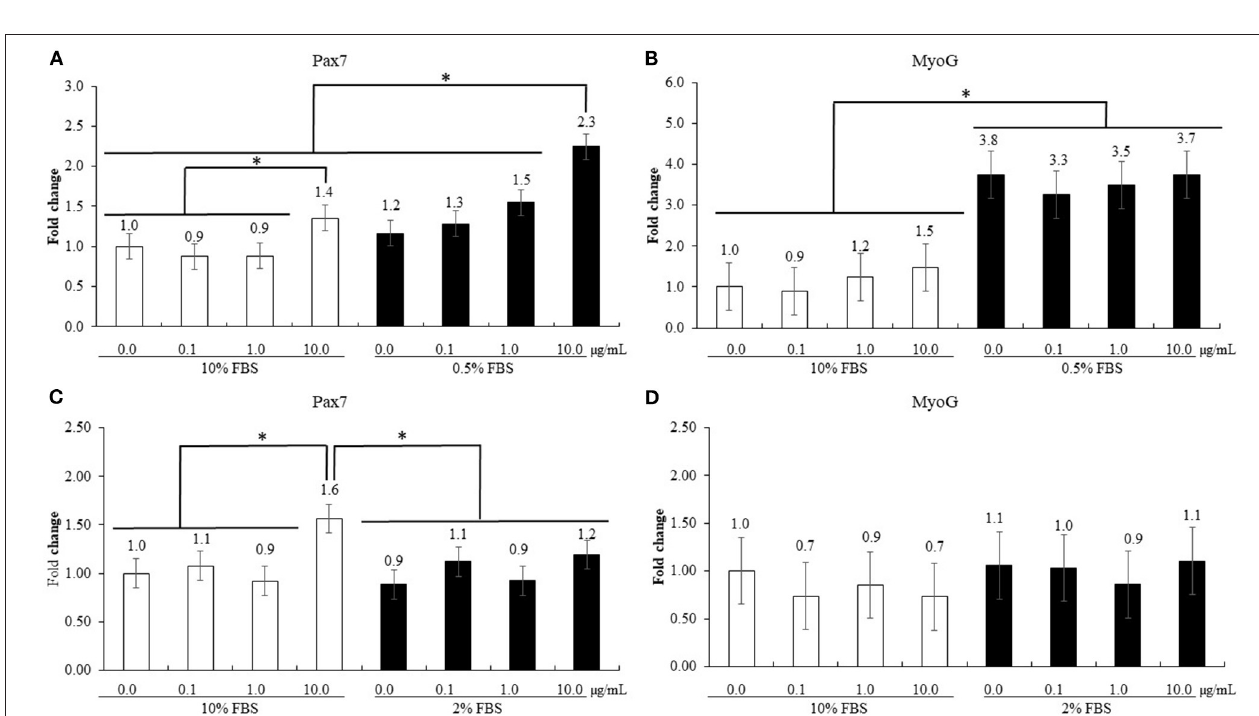
FIGURE 6 | Proliferation and differentiation of quail muscle cells [QMC, ( A,B )] and primary chicken embryonic muscle cells [PMC, (C,D) ] by FBS concentration and maltol. Each bar represents the mean ± SEM ( n = 3). Transcript levels of the cytokines were measured using quantitative RT-PCR and normalized to GAPDH transcript levels. Significant results are marked as follows: * ( P < 0.05).